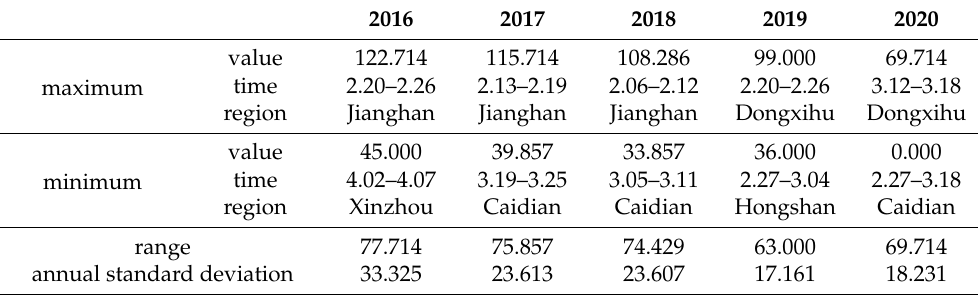
Table 6. PM 10 maximum/minimum statistics from 2016 to 2020.